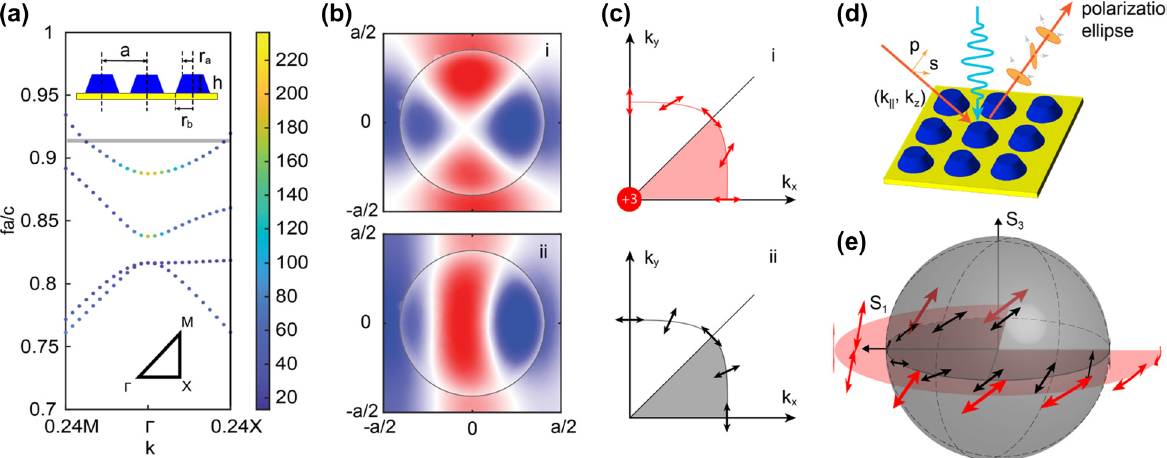
Figure 1: ZnO/Ag hybrid metasurfaces for all-optical manipulation of light polarization. (a) The band diagram of the ZnO/Ag hybrid metasurface made of a ZnO nanodisk array deposited on an optically thick Ag backplane. The color of the markers represents the corresponding radiative Q -factor. A side-view schematic of the hybrid metasurface is also presented as = 270 nm, r = 450 nm, h = 180 nm, and square lattice with a = 1100 nm. (b) Eigenmode profile of E an inset: r a b in-plane wavevector k ‖ parallel to the (i) Γ M direction, and (ii) Γ X direction, respectively. (c) On-resonance SOPs of the (i) eigenmodes, and (ii) scattering field when the system is illuminated by s -pol light. (d) Schematic of the hybrid metasurface for reflection polarization switching based on a photoexcited large permittivity change in the ZnO resonators. (e) Quasi-linear SOPs of the eigenmodes (red arrows) on the equator of a Poincare sphere when k ‖ moves on the iso-frequency contour. The corresponding SOPs of the scattering field (black arrows) are also presented for